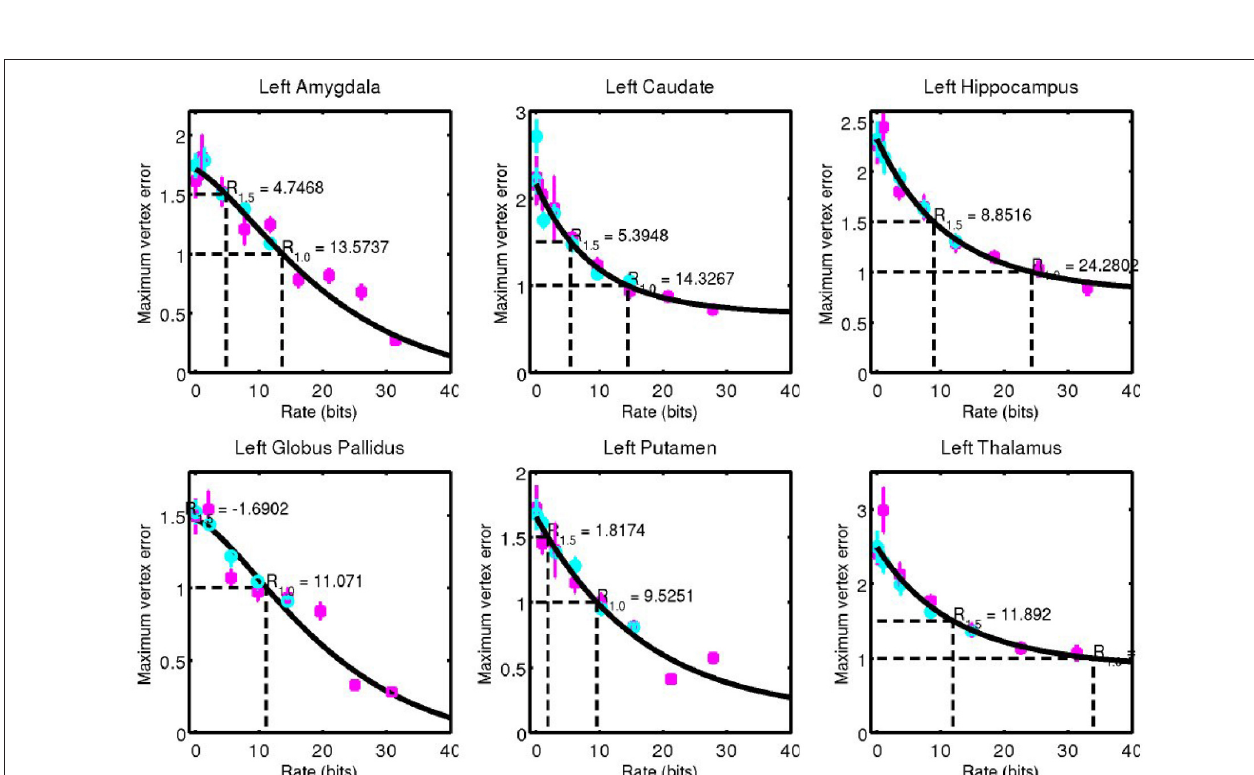
FIGURE 7 | Hausdorff distance between example surfaces and closest codeword. Coding one structure is shown in magenta, and two structures simultaneously is shown in cyan. The black curve is a simple fit through the data (not a model), and is used for estimating code rate at 1 and 1.5mm geometric error.